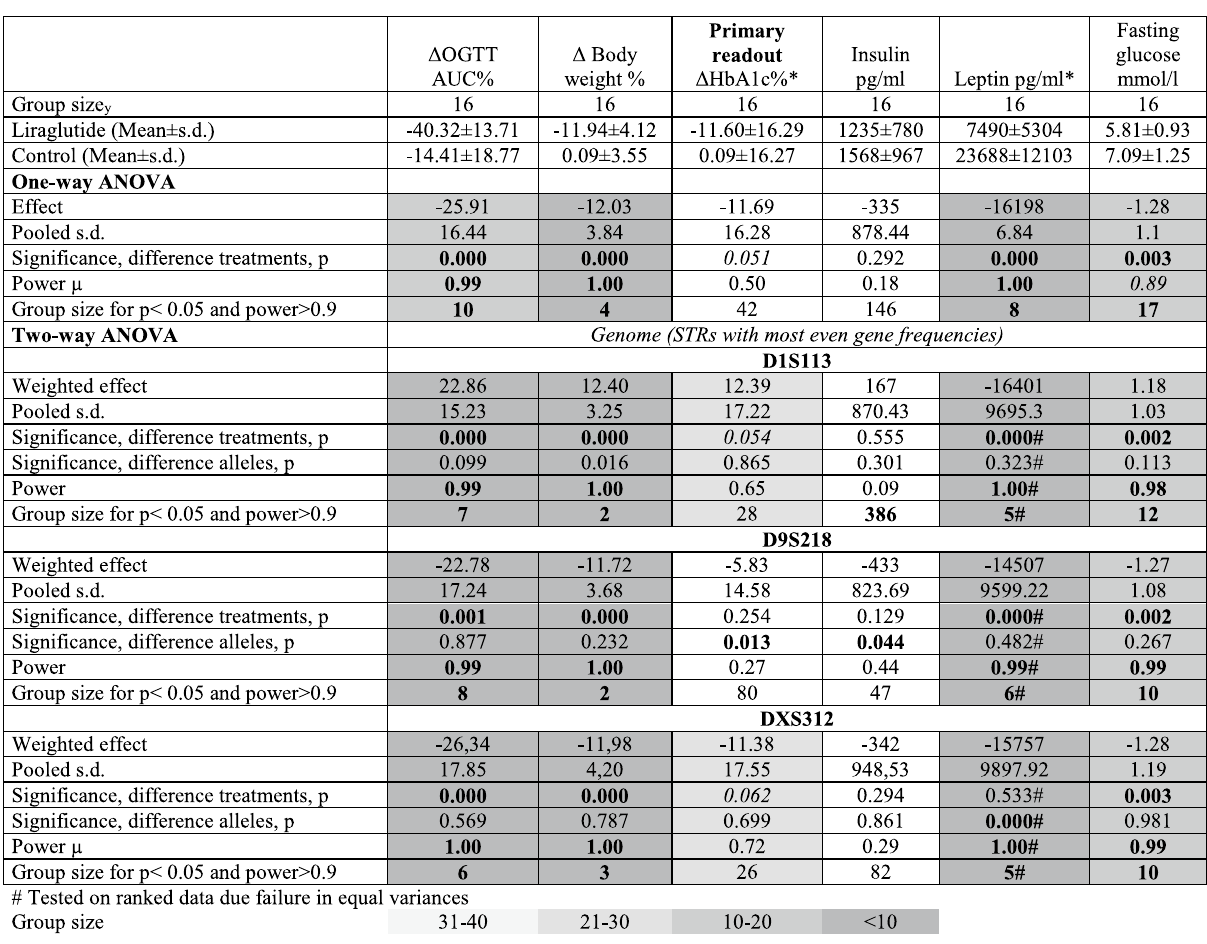
Table 3. Clinico-chemical parameters from testing the effect of liraglutide in diet-induced obese C57BL/6NTac mice and the subsequent evaluation by either one-way ANOVA or two-way ANOVA including alleles with the most even gene frequencies as a factor. Group sizes are written in bold if they are lower than the actual efficient group size. p < 0.05 are written in bold, p = 0.05 -0.010 are written in italics. Power is written in bold if > 0.90 and in italics if 0.80 - 0.90. Significant values are in bold. Italics: borderline significance (p <